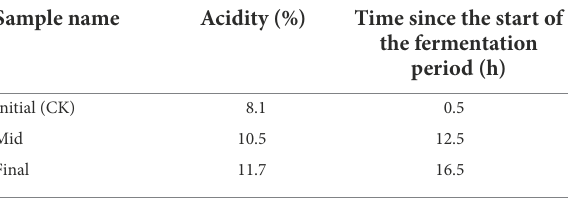
TABLE 1 Sample information of the transcriptomic